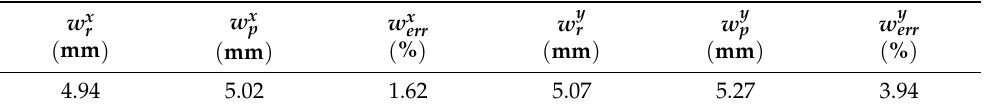
Table 11. The comparison between the weld width of the measured weld and the weld width of the recon-structed weld pool surface after robustness